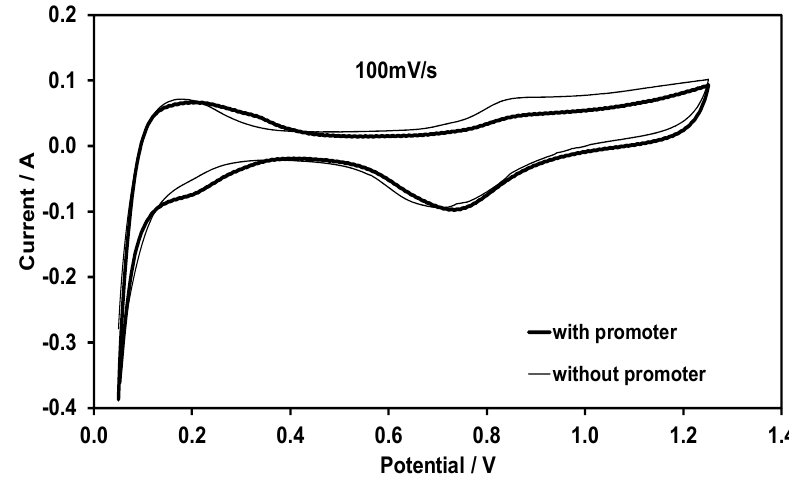
Figure 9. Cyclic voltammetry analysis at 80 °C, 100% R.H. for the PtCo-based catalytic layer with and without promoter; sweep rate 100 mV·s − 1 .